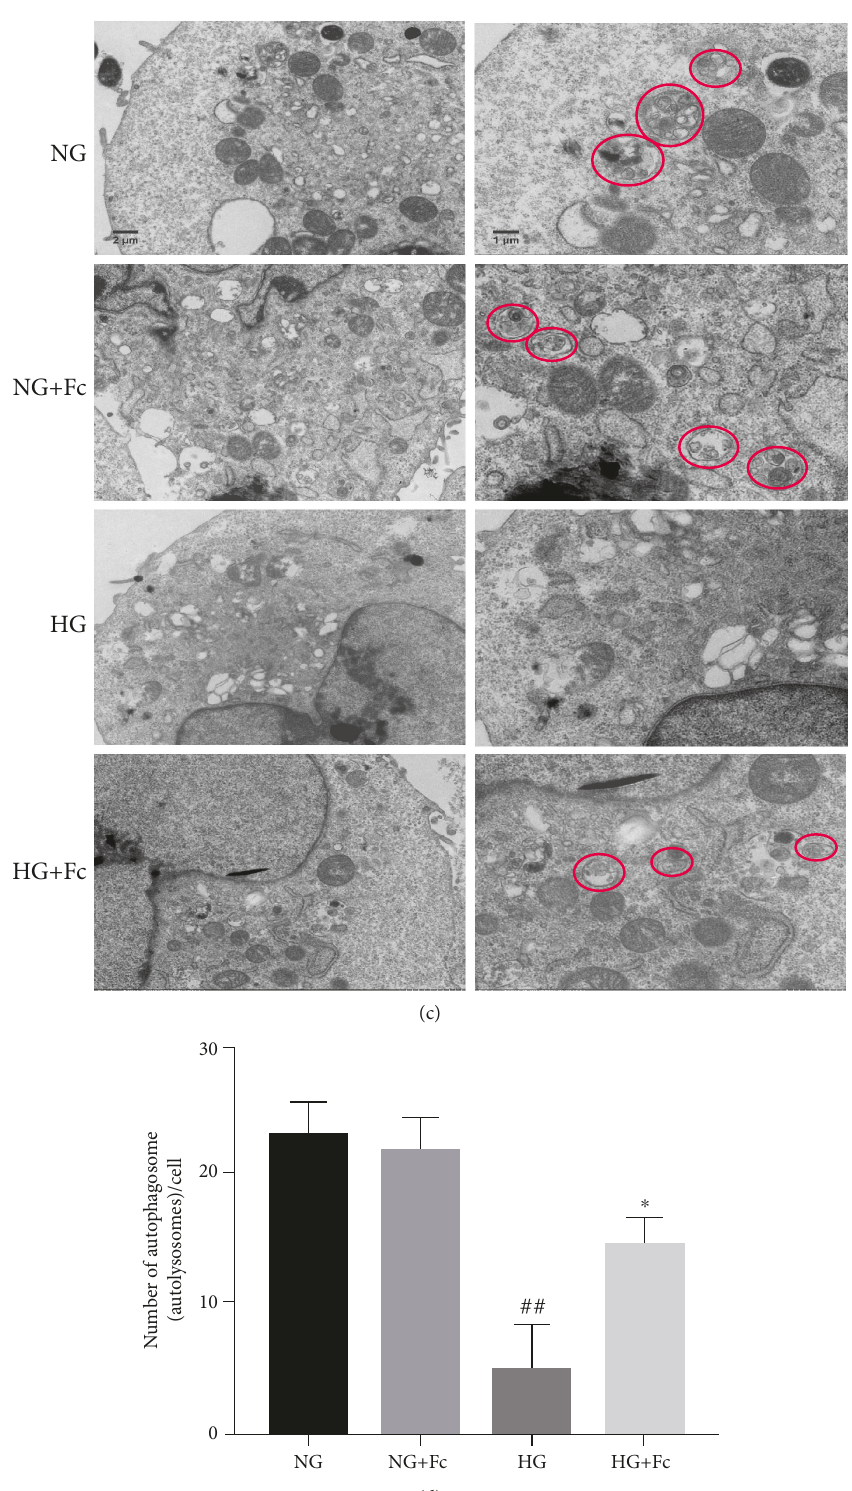
Figure 6: Notoginsenoside Fc (Fc) prevents HG-induced autophagy reduction in rat aortic endothelial cells. (a, b) The mRFP-eGFP-LC3B plasmid was transfected into cells and visualized by confocal microscopy. Representative images show puncta formation in di ff erent groups and the quantitative analysis of three types of puncta (8 cells per group). Scale bar = 10 μ m . (c, d) Representative images and quantitative analysis of autophagosomes in di ff erent groups assessed by electron microscopy (6 cells per group). Black arrows indicate autolysosomes/amphisomes and red arrows indicate autophagosomes. Scale bars = 2 μ m and 1 μ m . # P < 0 05 and ## P < 0 01 vs. the normal-glucose (NG) group; ∗ P < 0 05 and ∗∗ P < 0 01 vs. the high-glucose (HG) group. n = 3